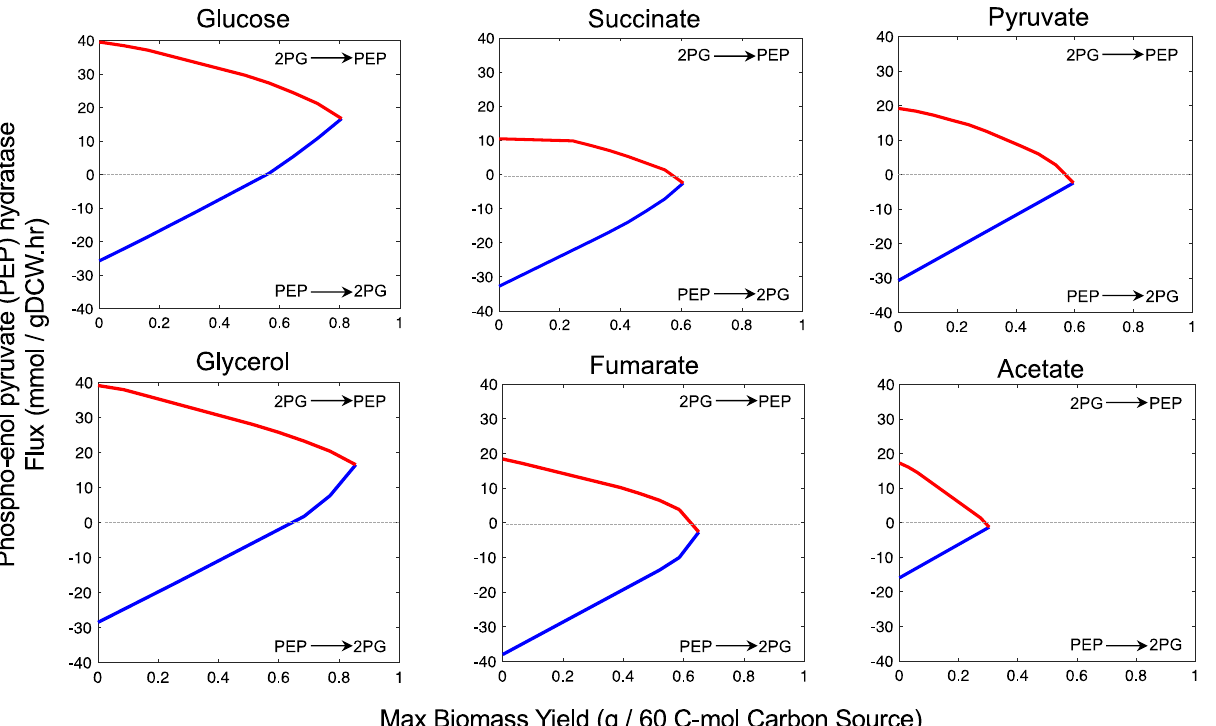
Figure 4. Flux variability analysis showing PEP utilization capacity represented by the flux through PEP hydratase as a function of cellular biomass yield for different carbon sources predicted by the iEco-F420 metabolic model of E. coli . Minimum and maximum fluxes are shown as blue and red, respectively. PEP: phosphor-enol pyruvate; 2PG: 2-phospho glycerate. Horizontal dashed lines do not correspond to any actual flux values; instead, they serve as hypothetical lines above which glycolysis drives carbon flow (2PG is metabolised to